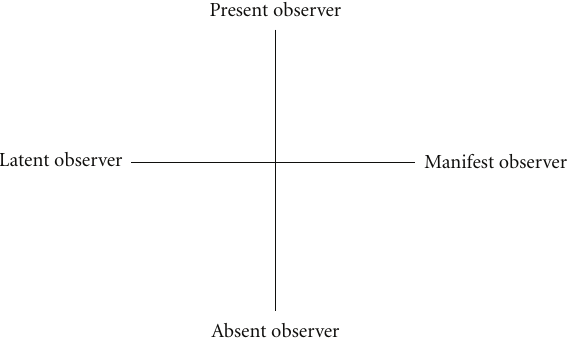
Figure 1: The powerful scheme of observation and surveillance